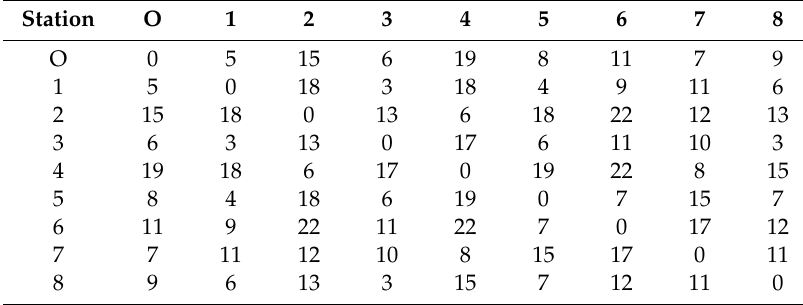
Table 4. The shortest travel distances in kilometers (km) between each station retrieved from OpenStreetMap using Python 3.7.